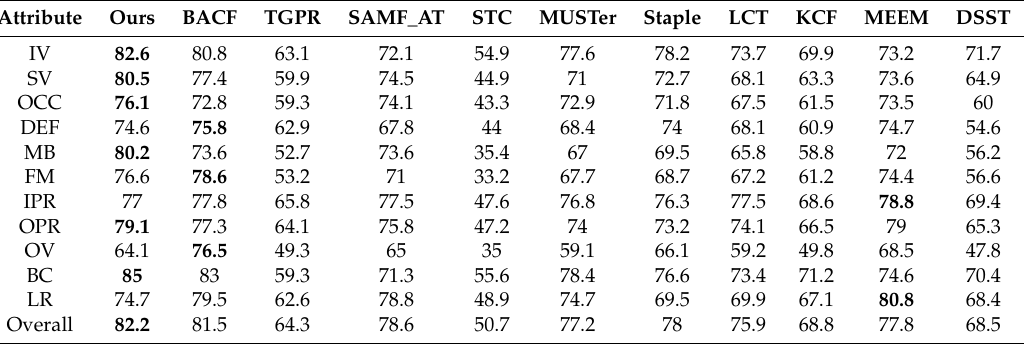
Figure 6. Performance evaluation of our method and BACF on the OTB-2015 dataset. Table 1. Comparison of our tracker with other state-of-the-art trackers on 11 different attributes of the OTB-2015 dataset. Average precision scores (%) at a threshold of 20 pixels are presented. The optimal results are highlighted in